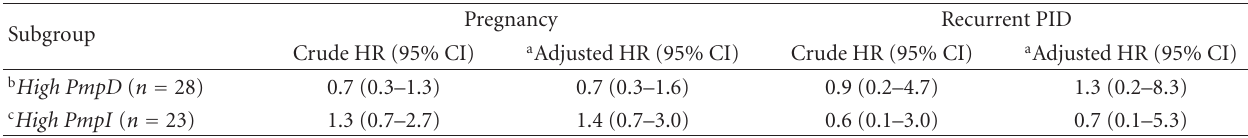
Table 5: E ff ect of Pmp antibody reactivity on time-to-pregnancy and time-to-recurrent